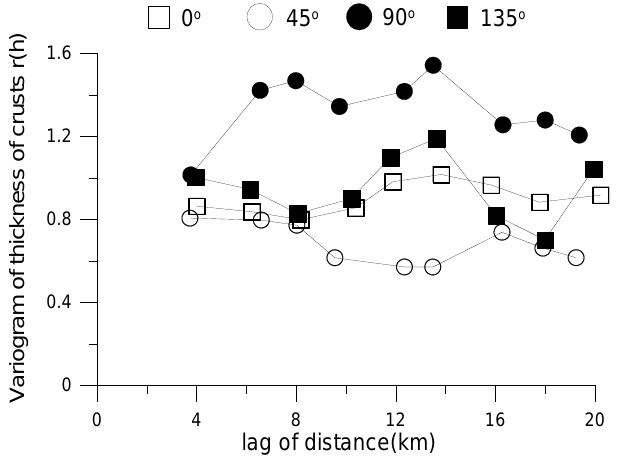
Figure 4. Experimental distance/orientation-based variograms. 0 °, 45°, 90°, and 135° (measured clockwise from north) are the four orientations in which the point pairs are searched to calculate the variograms (by Du et al., 2017 [17]).